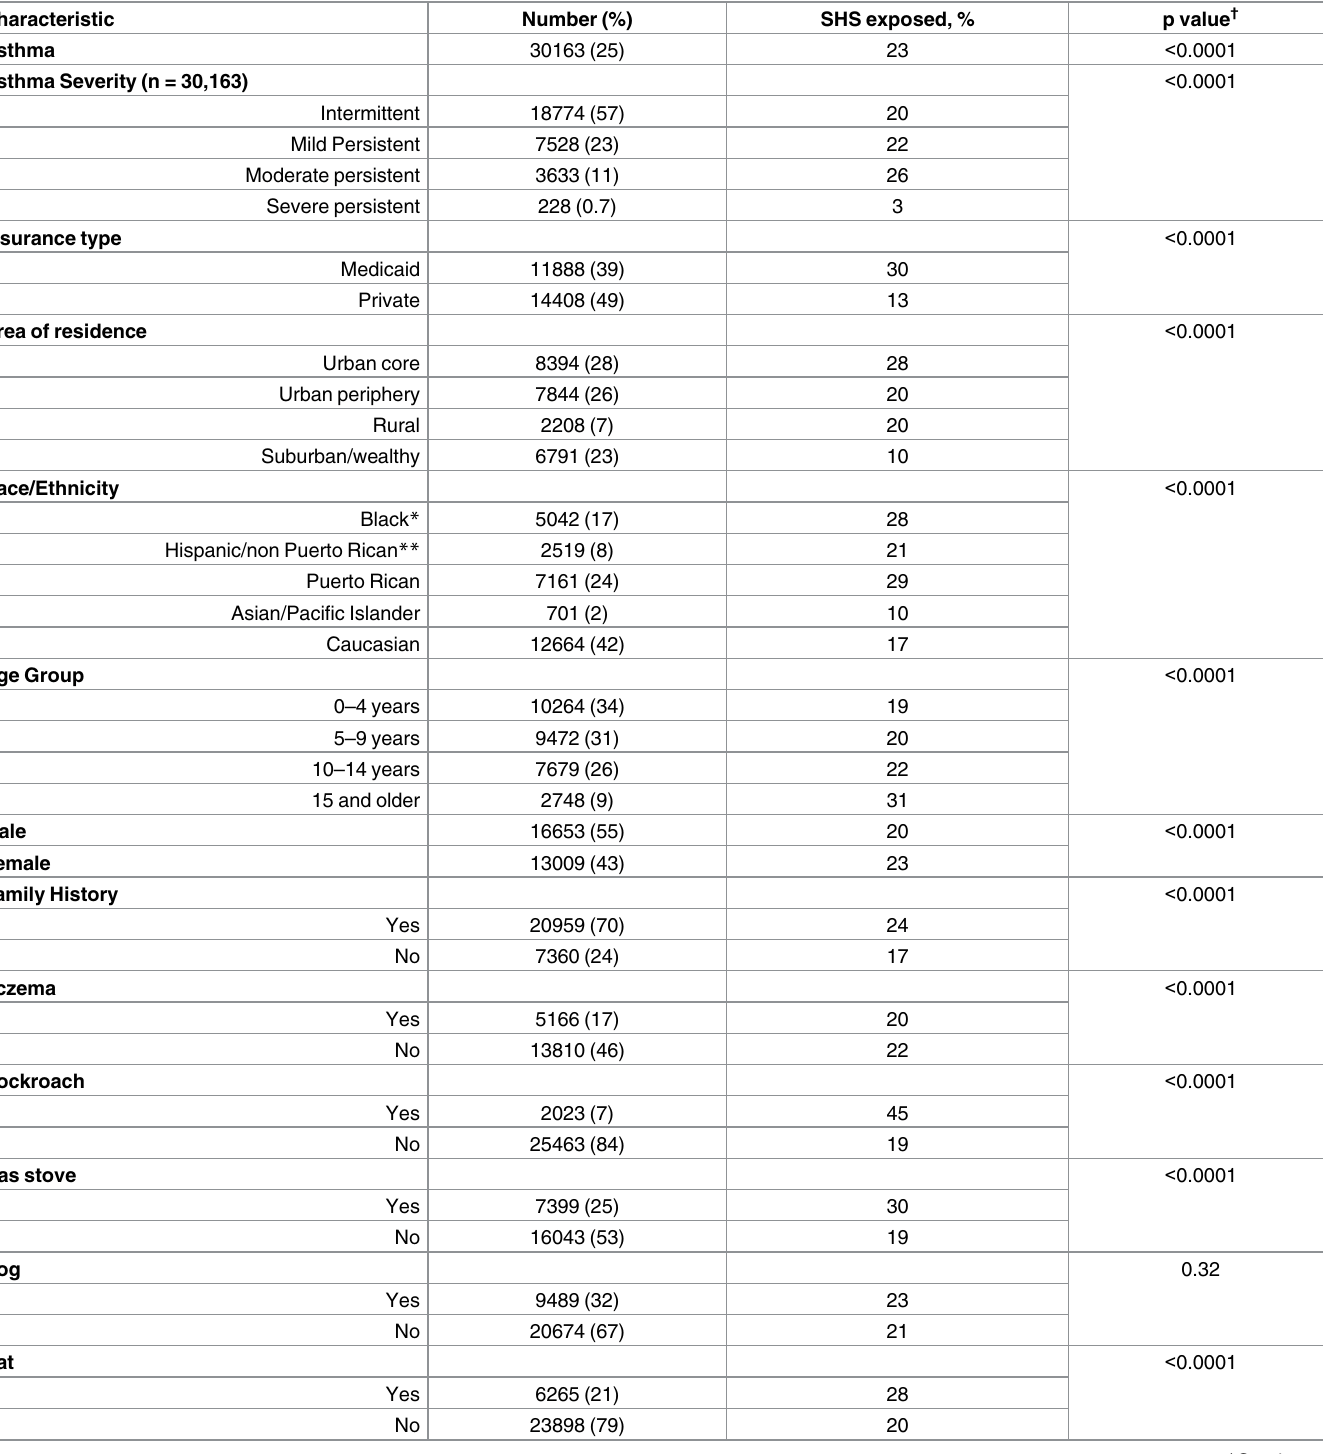
Table 2. Demographics of children with a documented asthma severity enrolled in Easy Breathing and SHS exposure status.